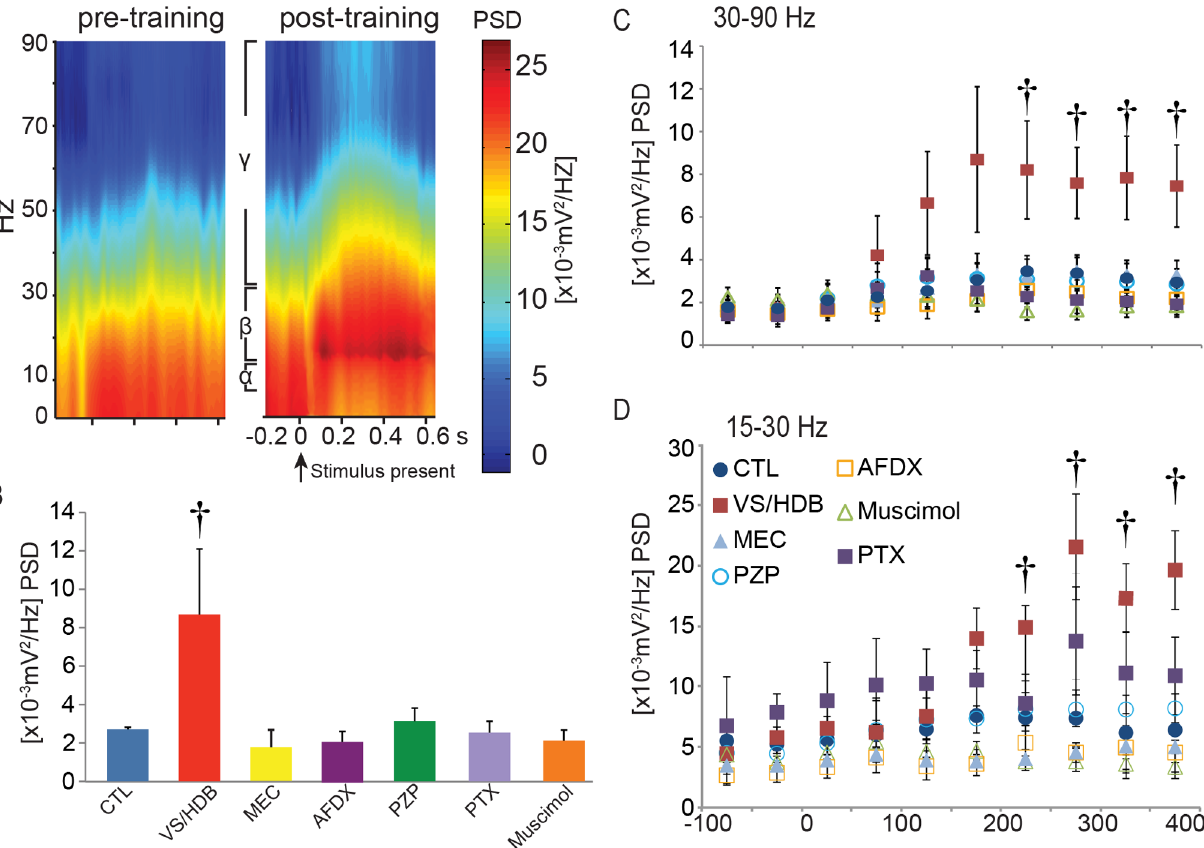
Fig 4. Time-frequency VEP analyzes. A) Representative comparison of the power spectral densities (PSDs) of the pre- and post-training VEPs from the VS/HDB group as analyzed with the short-time Fourier transformation. B) Comparison of the PSDs in the 200 – 250 ms time window after the stimulus presentation. Only the VS/HDB group exhibited an increase in gamma band oscillations ( † , one-way ANOVA, p < 0.05). Gamma (C) and beta band (D) power during VEP recording. There was an increase of beta (15 – 30 Hz) and gamma band (30 – 90 Hz) power 200 – 250 ms after stimulus onset.